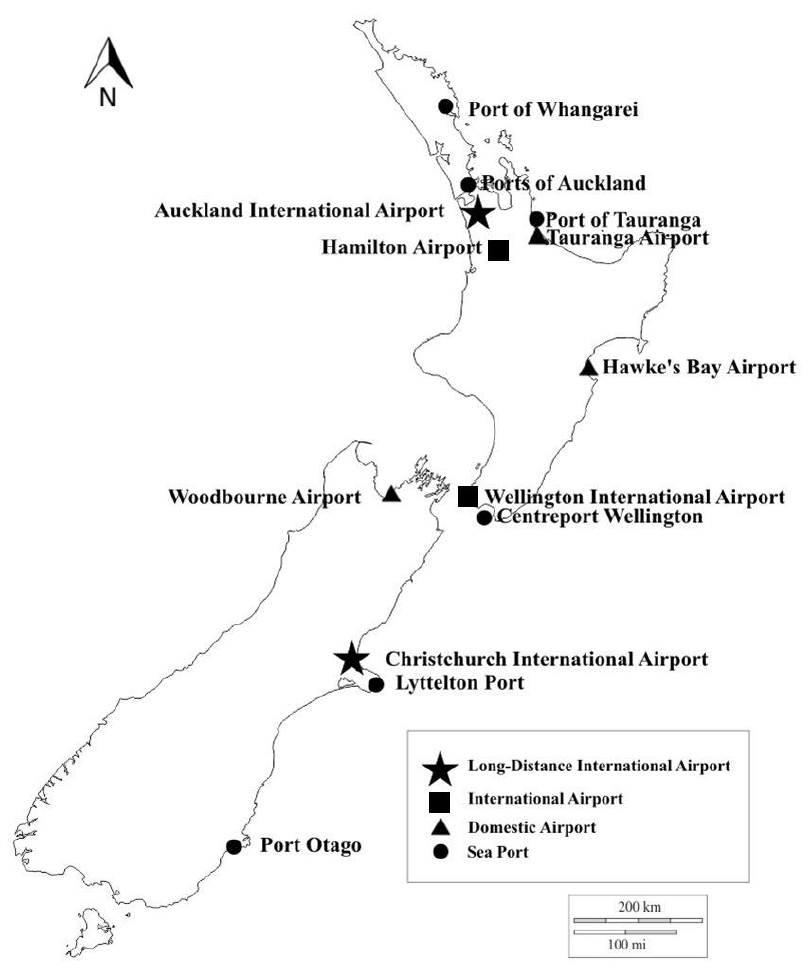
Figure 1. Ports of entry of mosquito interceptions in New Zealand, July 2001 — March 2018.